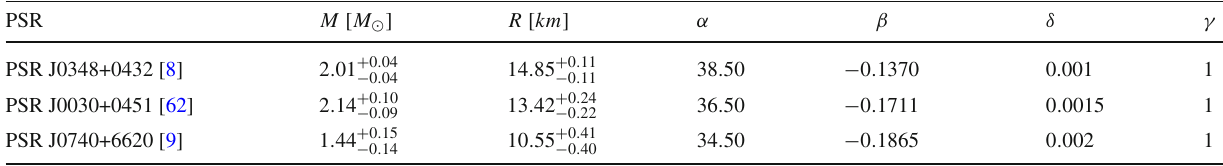
Table 1 Constant parameters calculated for radii and mass for some heavy pulsars